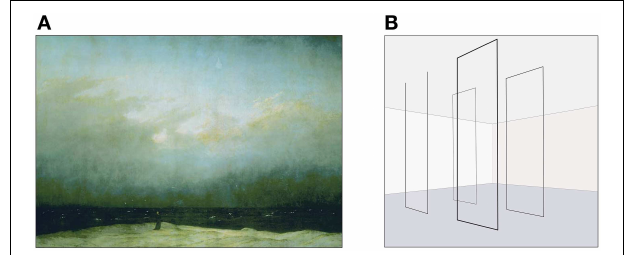
FIGURE 1 | Examples of tear-inducing art. (A) Caspar David Friedrich, Der Mönch am Meer, 1808–1810. (Oil on canvas, 110 × 171 .5cm. public domain image, Wikimedia commons). (B) illustration depicting archetypal Fred Sandback work (image created by first